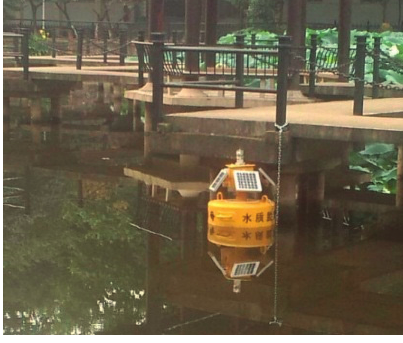
Figure 1. A prototype of aquatic sensor